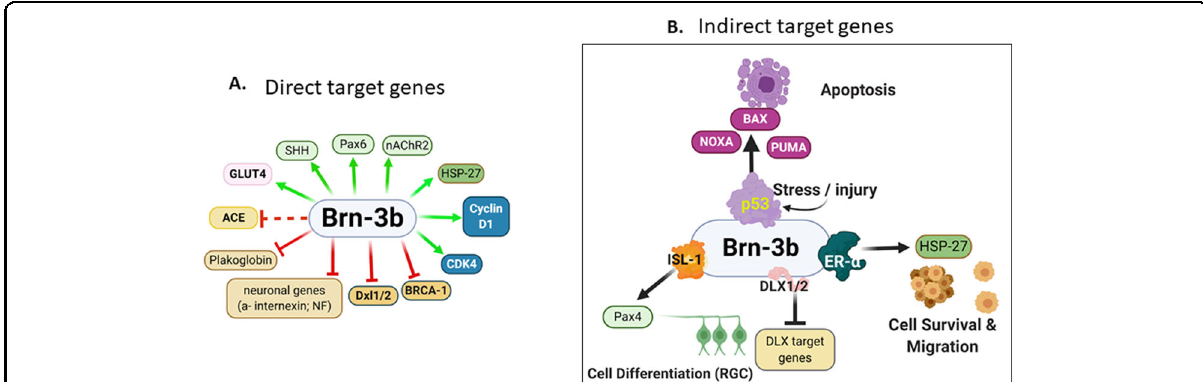
Fig. 3 Schematic diagram showing the effects of Brn-3b on known target genes. A Representation of known target genes that are directly regulated by Brn-3b. Green arrows indicate genes that are directly activated activated by Brn-3b and red bars represent genes that are repressed. B Shows genes that are indirectly regulated by Brn-3b, upon interaction with other cellular proteins, including the oestrogen receptor alpha (ER- α ), p53 tumour suppressor gene; ISL1 and DLX proteins, as indicated. The effects on cell fate are also